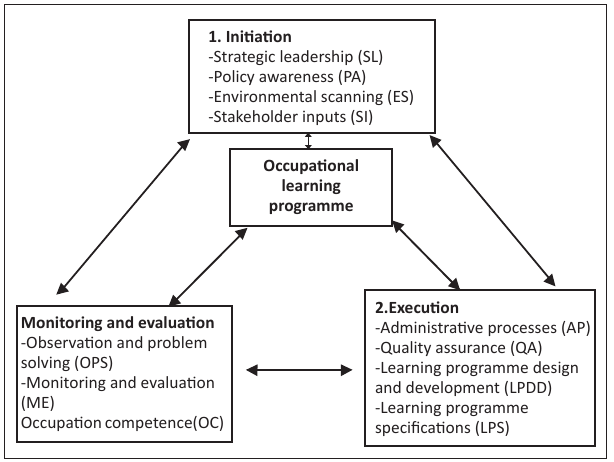
FIGURE 1 : Phases and dimensions for the effective management and evaluation of occupational learning